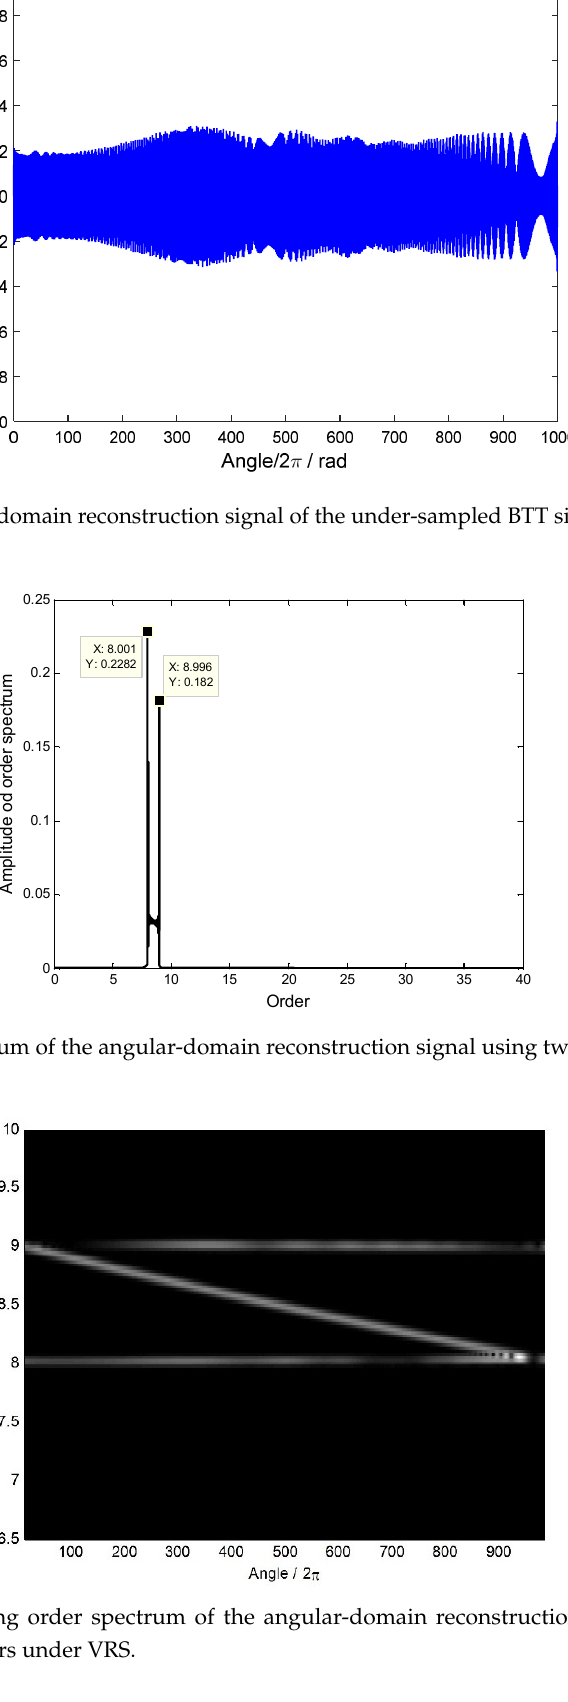
Figure 17. Waterfall of the angular-domain reconstruction signal using two non-uniform BTT sensors under VRS. 5. Experimental Validations 5.1. Experimental Set-Up To further validate the proposed BTT vibration reconstruction algorithms, an experimental rig of BTT-based vibration monitoring of high-speed rotating blades was built as Figure 18. The whole experimental system was composed of a supporting base, an electrical motor, a testing bladed disk, a magnetic exciter, three optical fiber BTT sensors, a once-per-revolution reference sensor, and a protection cover. The electrical motor was mounted under the supporting base. BTT sensors were fixed around the bladed disk through the holes in the protection cover. An angular scale was 650 700 750 800 850 900 510052005300540055005600 0.51